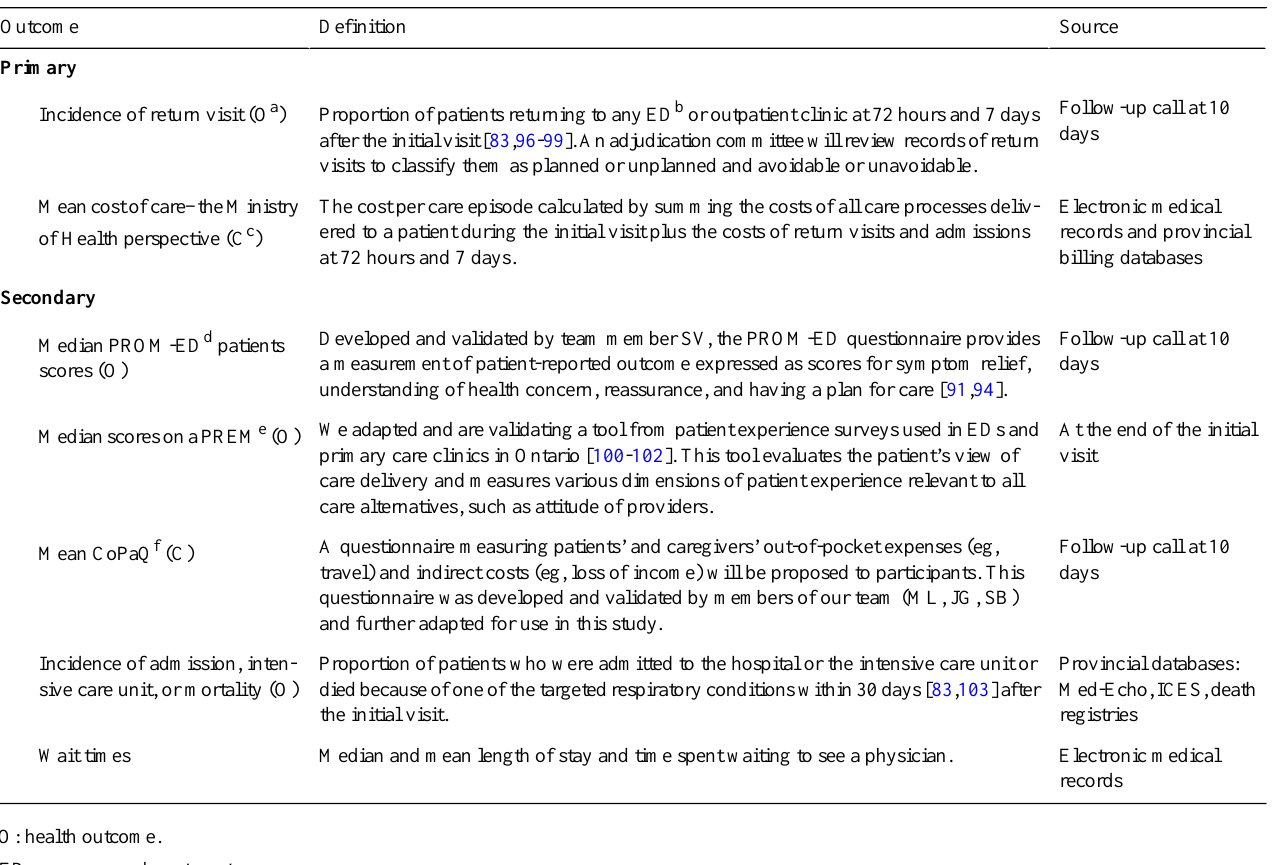
Table 2. Main study